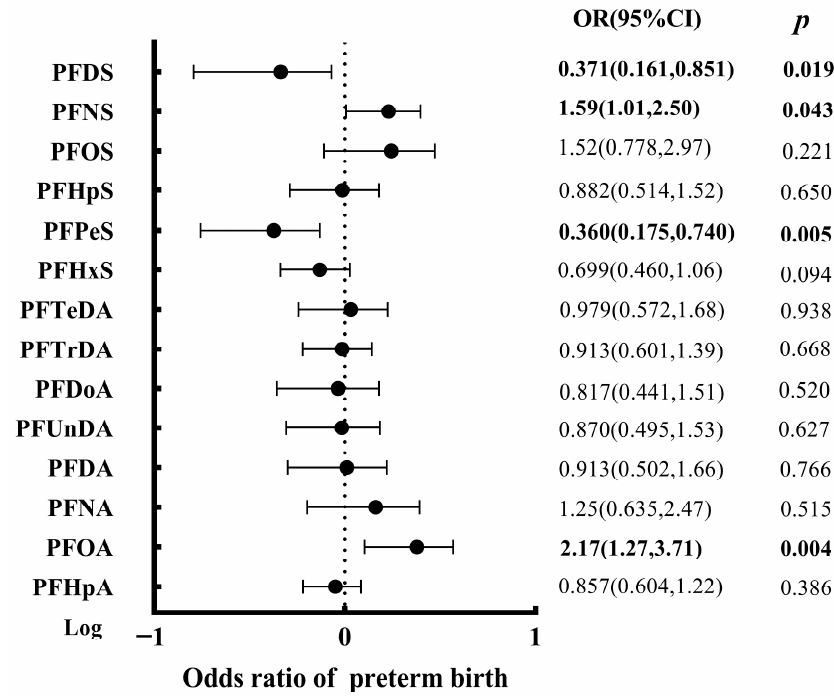
Figure 4. Odds ratios (ORs) [95% confidence interval (CI)] for preterm birth by serum concentrations of PFASs in logistic regression analyses. Notes: preterm birth risk was estimated for continuous log- transformed PFASs concentrations in serum; The model was adjusted for maternal age, prenatal BMI, education, occupation, smoking, alcohol drinking, ethnicity, delivery mode and parity.